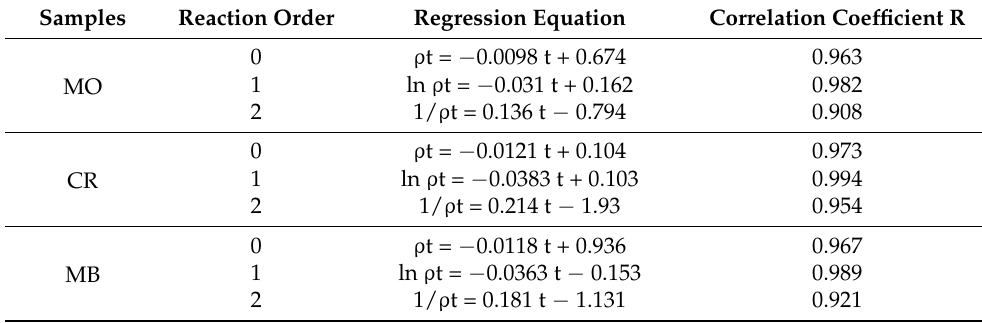
Table 3. The photocatalytic degradation kinetics of MO, RhB, and CR.